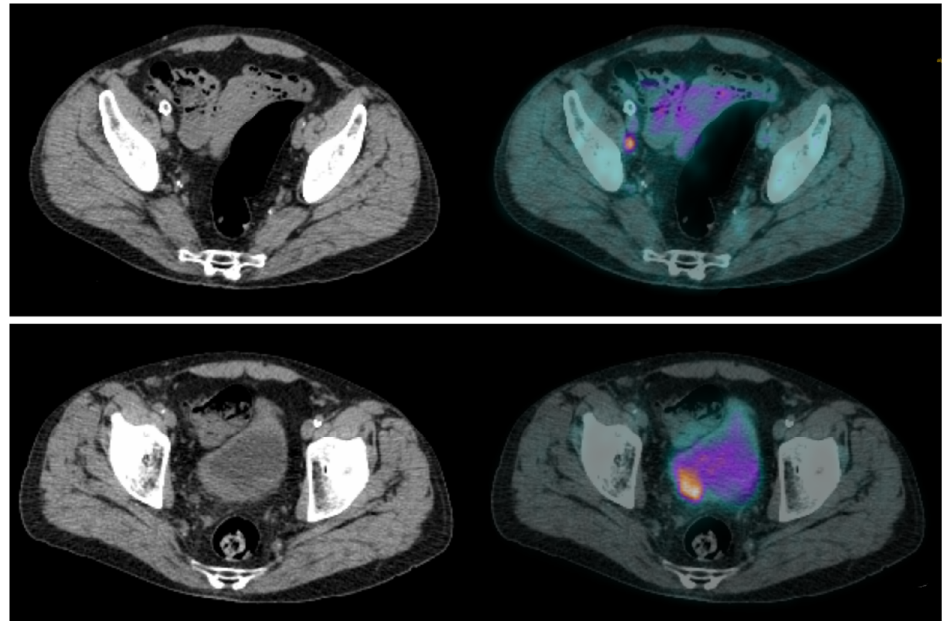
Figure 2. CT and fused FDG-PET/CT images performed at initial staging of a MIBC for a 64-year- old patient. ( Bottom line ): Intense uptake of the residual primary tumor that was found pT3a at pathological analysis of the cysto-prostatectomy specimen. ( Top line ): Intense uptake of a single external iliac lymph node of 7 mm of short axis, which did not match criteria to be considered cN+ on CT alone. This lymph node was found pN+ at pathological analysis of the dissection specimen.